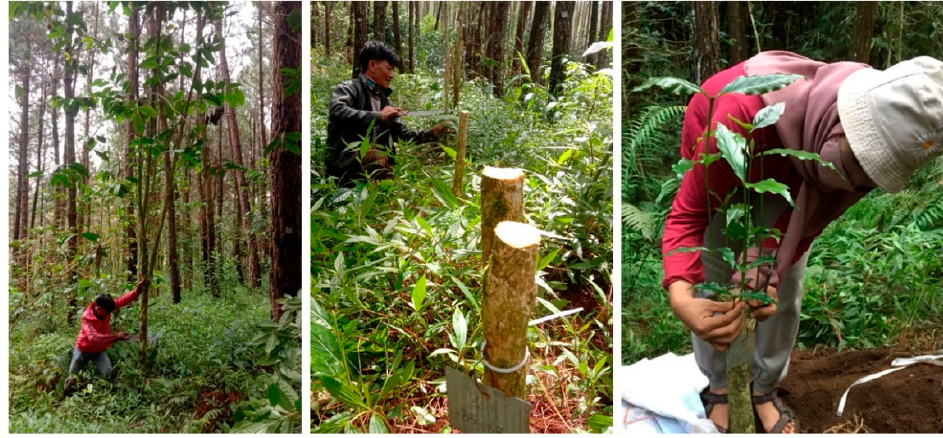
Figure 9. Photos showing pruning of overgrown coffee plants and measurements being taken of the regrowth following pruning.